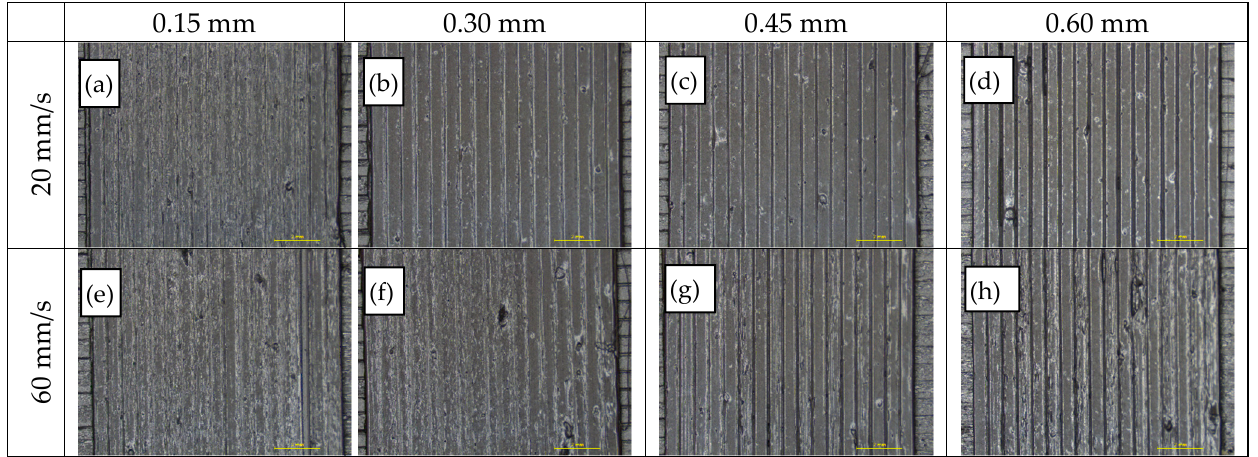
Figure 13. Optical inspection via stereomicroscope (7×) of specimens obtained from varying strand heights (SH) and printing speeds (PS): ( a – d ) SP = 20 mm/s and SH = 0.15, 0.30, 0.45, 0.60 mm from left to right; ( e – h ) SP = 60 mm/s and SH = 0.15, 0.30, 0.45, 0.60 mm from left to right.